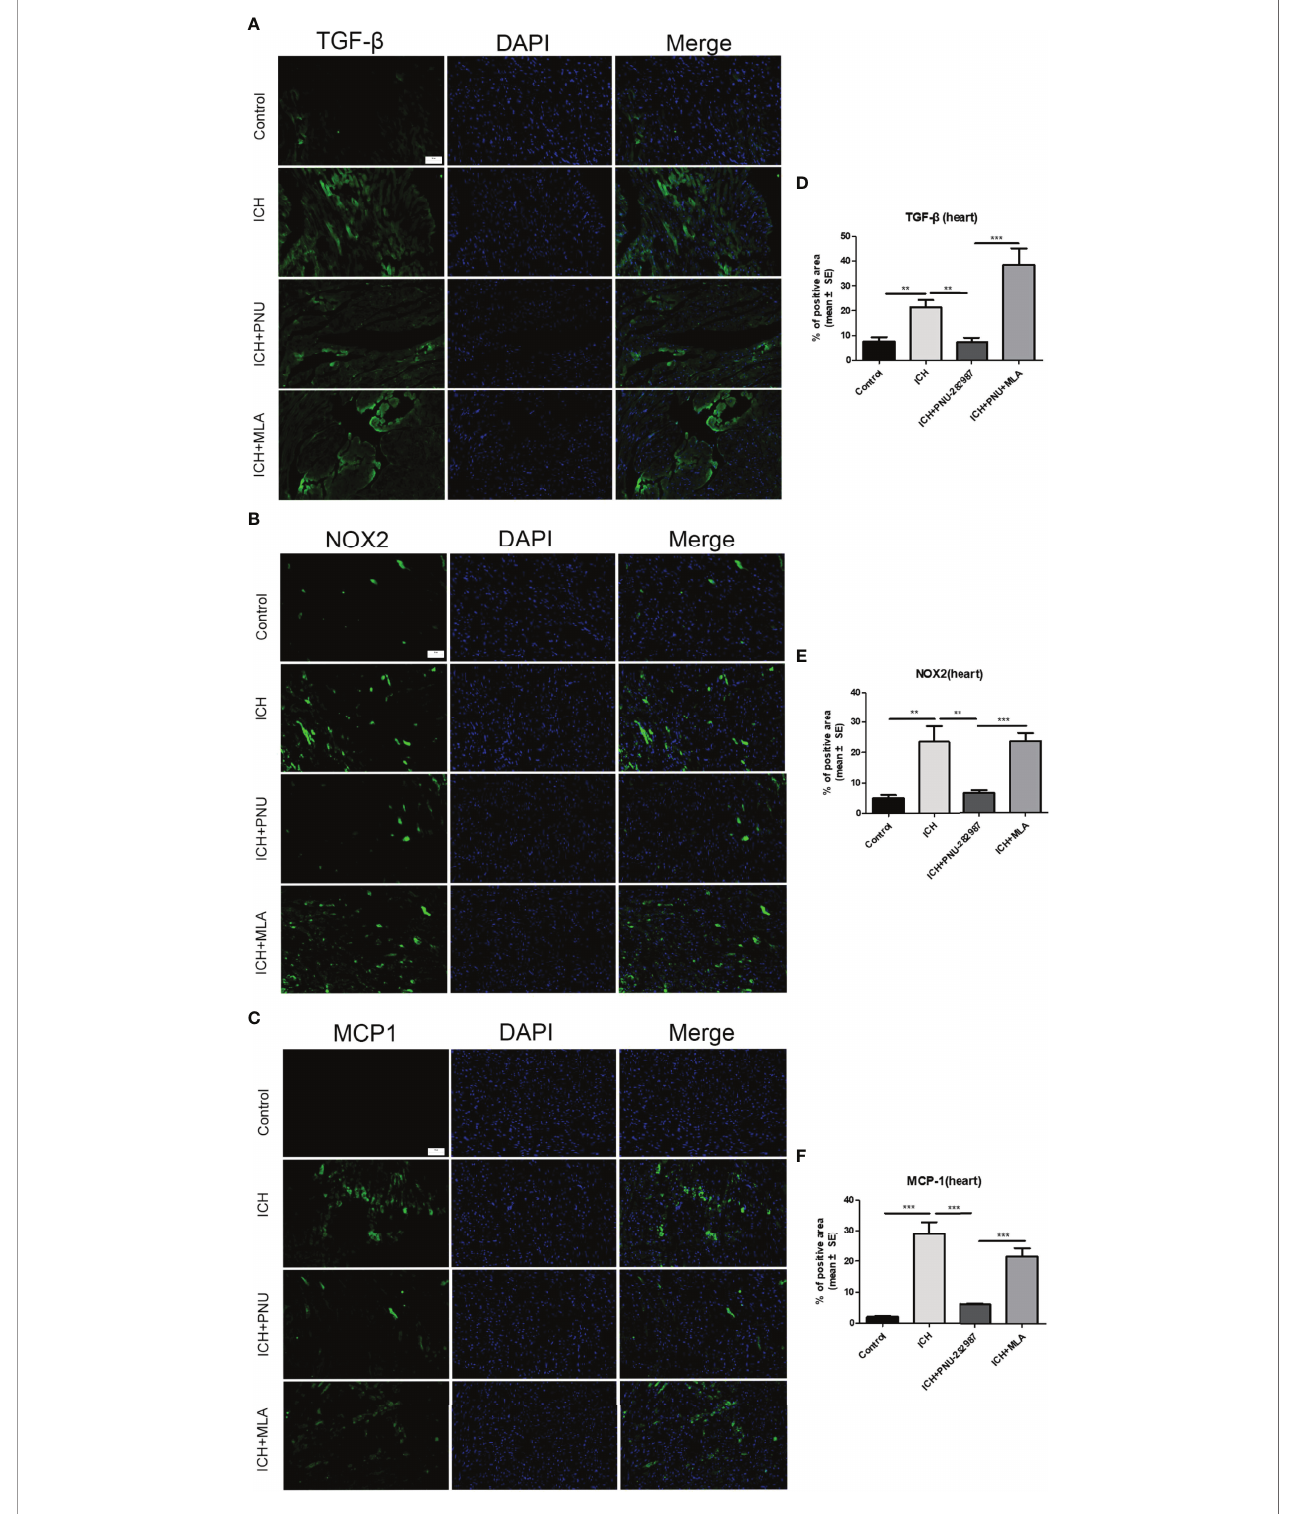
FIGURE 11 | Activating a 7nAChR decreased ICH-caused oxidative stress and in fl ammatory responses in the heart. Immuno fl uorescence images of in fl ammation factor of TGF- b (A) , NOX-2 (B) , MCP-1 (C) were compared in four groups in heart, (scale bar, 100 m m). Quantitative data of TGF- b (D) , NOX-2 (E) , MCP-1 (F) in heart. n = 6 per group. Data are presented as mean ± SE; **P < 0.01; ***P <